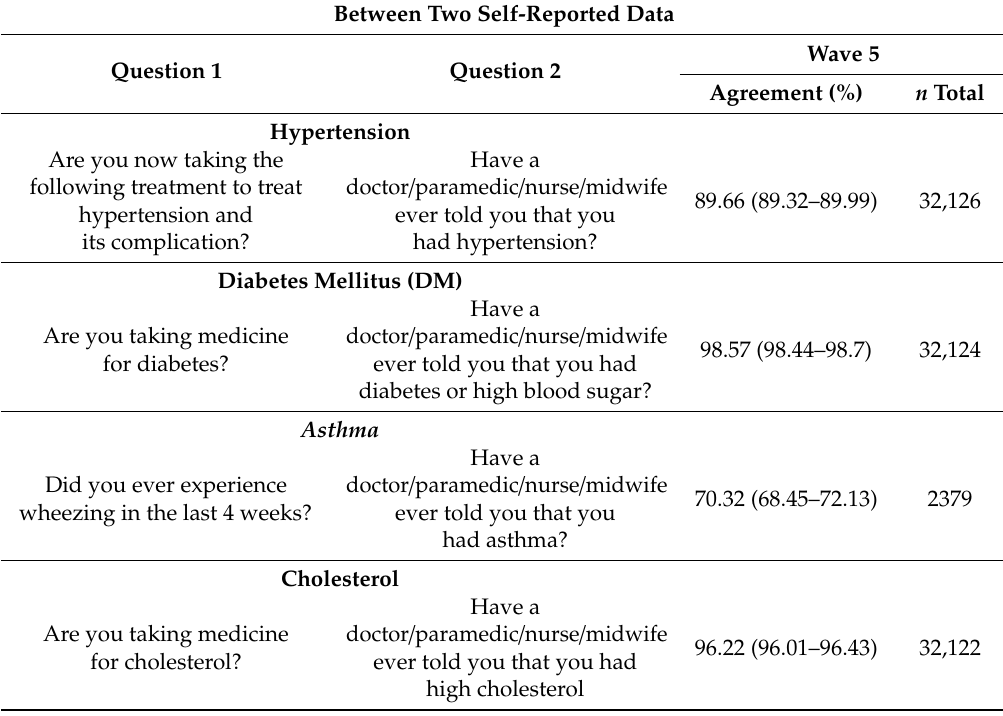
Table 4. Consistency of health outcome data based on Agreement of Self-Reported Questions (%, 95%